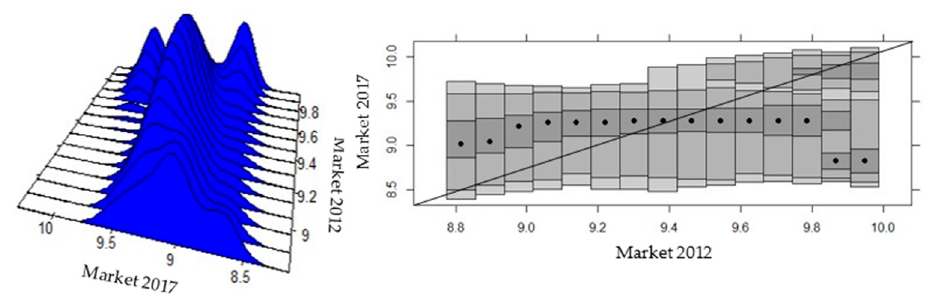
Figure 11. Intra-distribution dynamics of provincial productivity in the market service subsector, 2012–2017.Source: Own elaboration based on the Regional Accounts of the BCE [46]; ENEMDU surveys from the INEC [47] (several years) and stacked conditional density plot (SCD) in R.